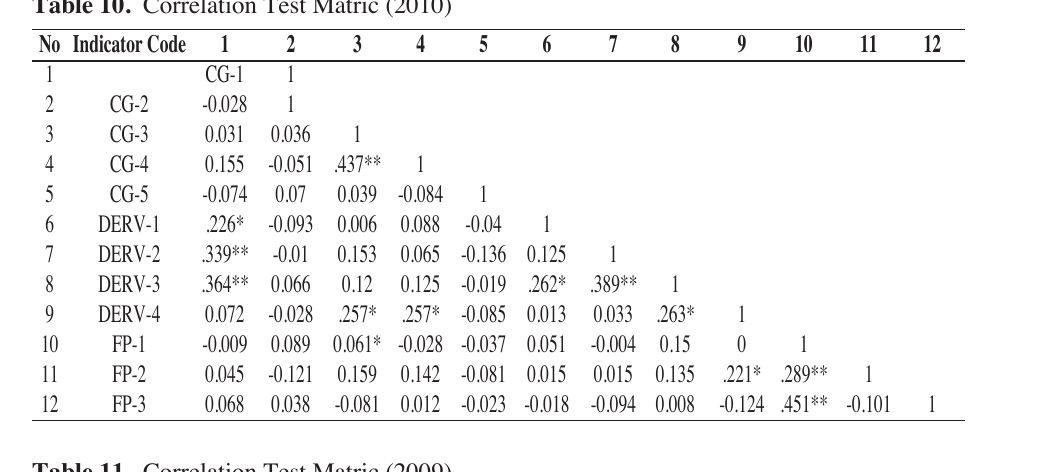
Table 11. Correlation Test Matric